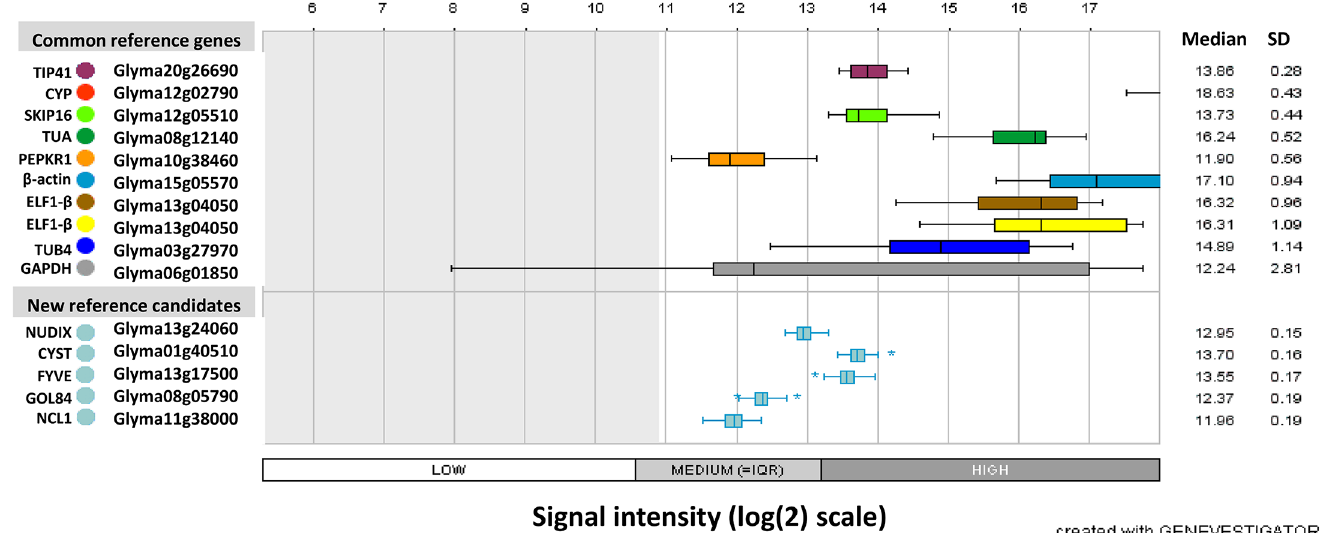
Fig 1. Expression of commonly used reference genes and new candidates from microarray databases. The in silico analyses were performed with Genevestigator software, using data from soybean subjected to drought stress, heat and different photoperiods[27]. The box plots represent the variation in the signal intensity (log 2 scale). Interquartile range (IQR) values are shown for each gene across the dataset, represented by the middle boxes, which encompass the middle 50% of scores for the group. The upper and lower whiskers represent scores outside the middle 50%. Outliers are plotted separately as asterisks on the